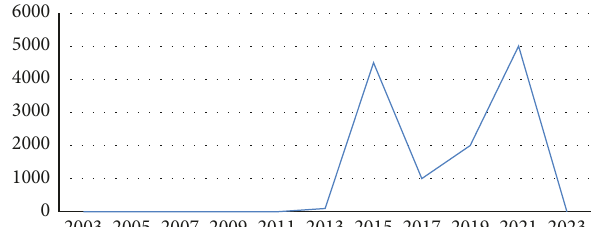
Figure 5: Article distribution by years for scoping review